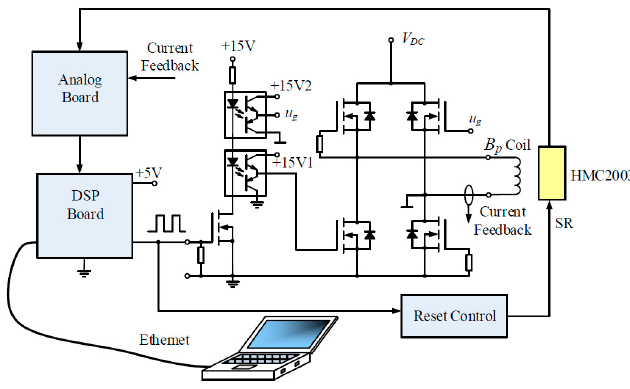
Figure 8. Detailed circuit diagram of the control electronics.